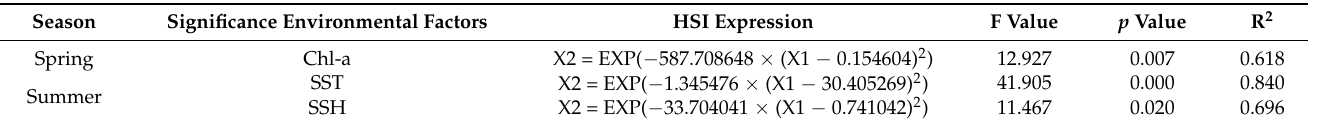
Table 5. SI model for each environmental factor that differed significantly between spring and summer.